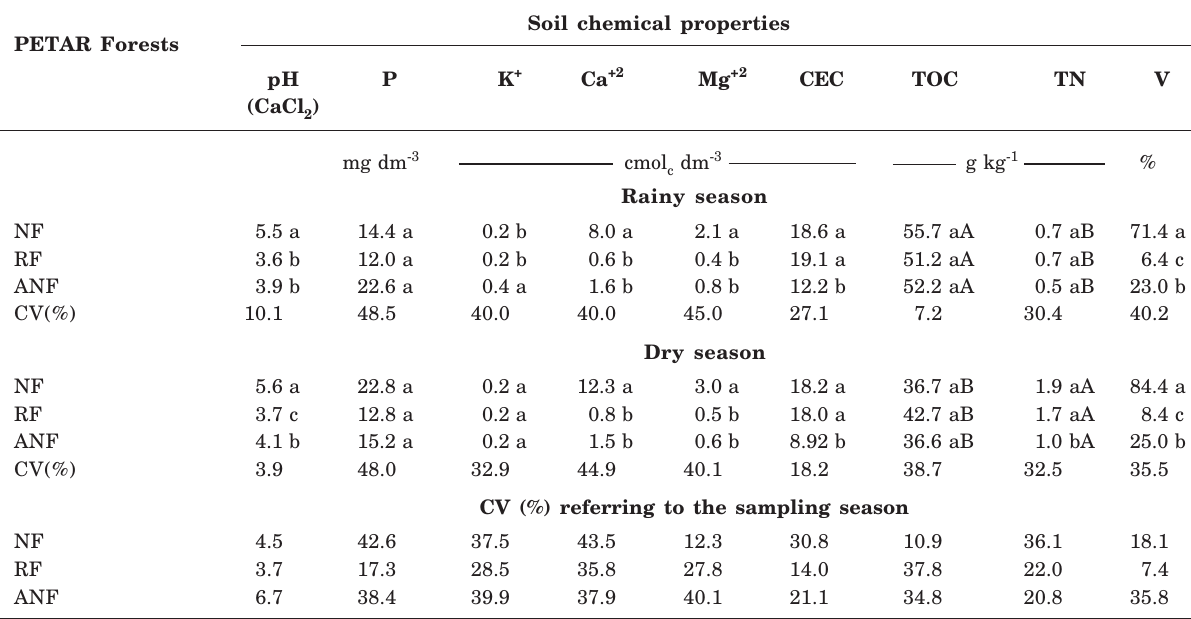
Table 2. Chemical properties of soils under different PETAR Araucaria forests